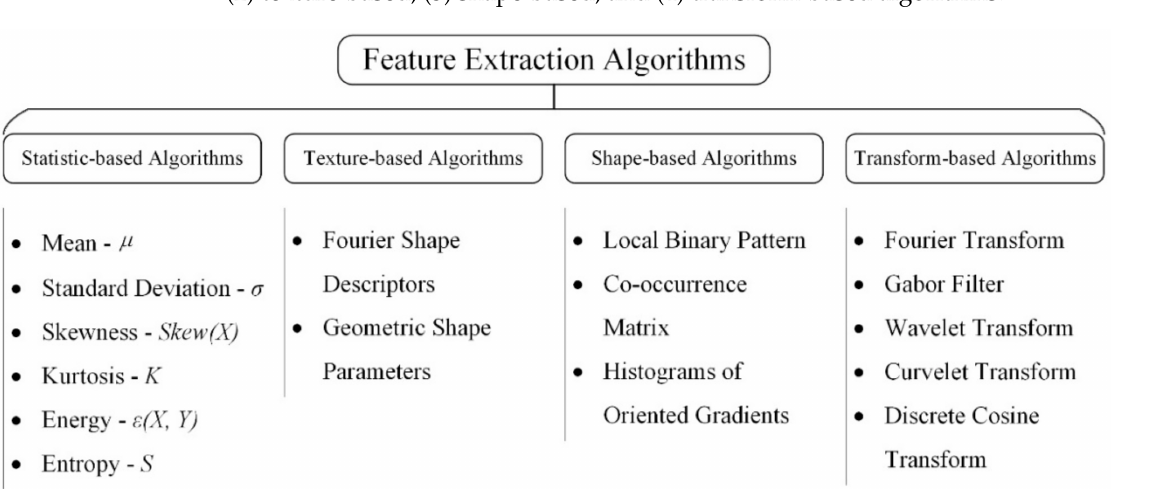
Figure 5. Taxonomy of feature extraction